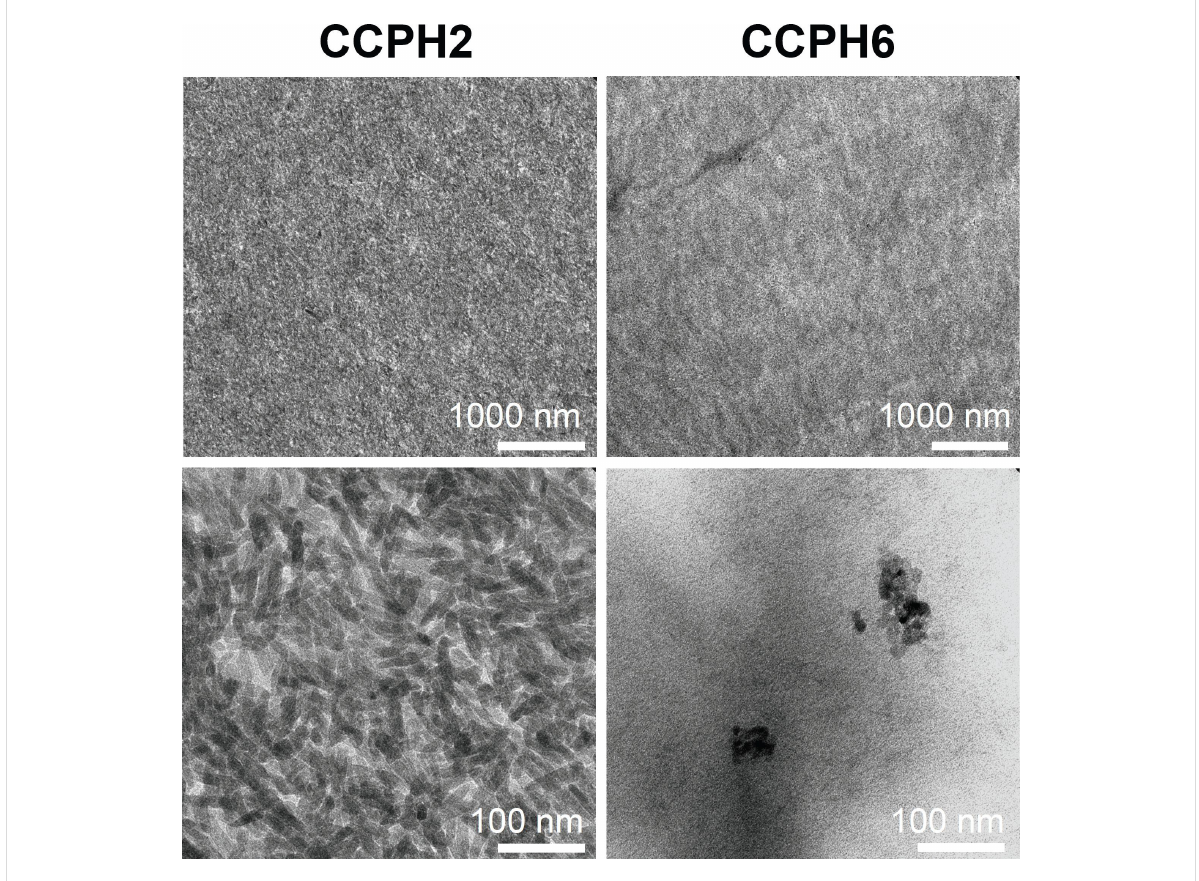
Figure 6: TEM images of thin sections of CCPH2 and CCPH6. Top row are low magnification and bottom row are high magnification images of the same samples.